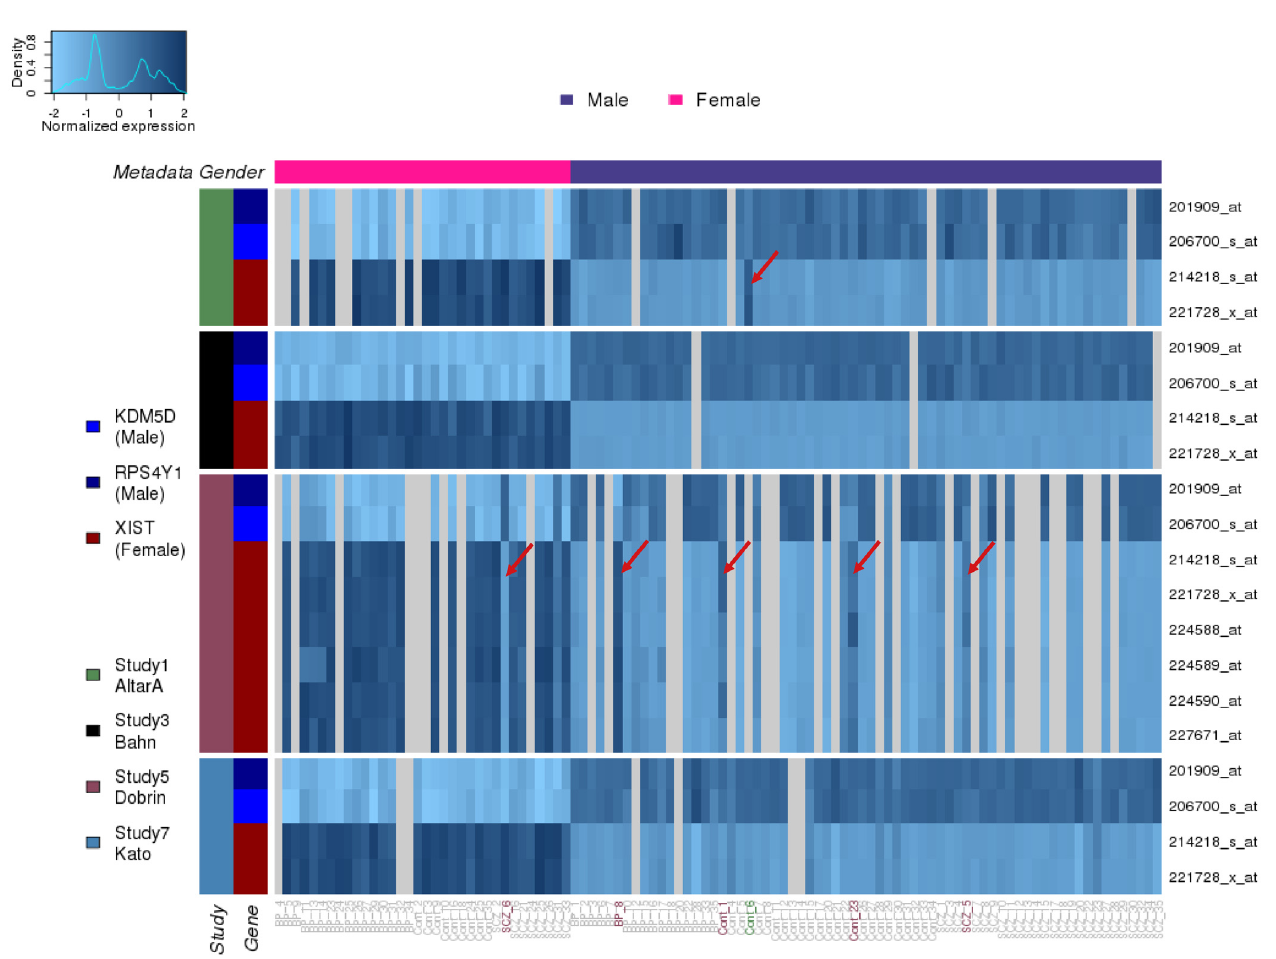
Figure 2. Gene-based and metadata-based sex in four datasets of similar subjects from Stanley Array collection. The heatmap represents z-transformed expression values of KDM5D , RPS4Y1 and XIST probeset in four datasets of microarray data from Stanley Array Collection cohort of subjects. The datasets are designated - Study1 AltarA, Study3 Bahn, Study5 Dobrin, Study7 Kato, in correspondence to their names on the Stanley collection site. Each column represents a subject and each raw represents a probeset. The four studies are represented on the left color bar on the side of the heatmap. The gene names corresponding to each probeset are shown by the right color bar on the side of the heatmap. Three of the studies – AltarA, Bahn and Kato were performed on the GPL96 platform on which XIST is represented by two probesets. The Dobrin dataset is on the GPL570 platform containing additional 5 XIST probesets, one of which was removed from the analysis. The annotated sex of each subject (metadata gender) is represented by the top color bar (females – pink, males – purple). Missing samples (samples that were excluded from the original studies) are shown in grey. Arrows point to the mismatched